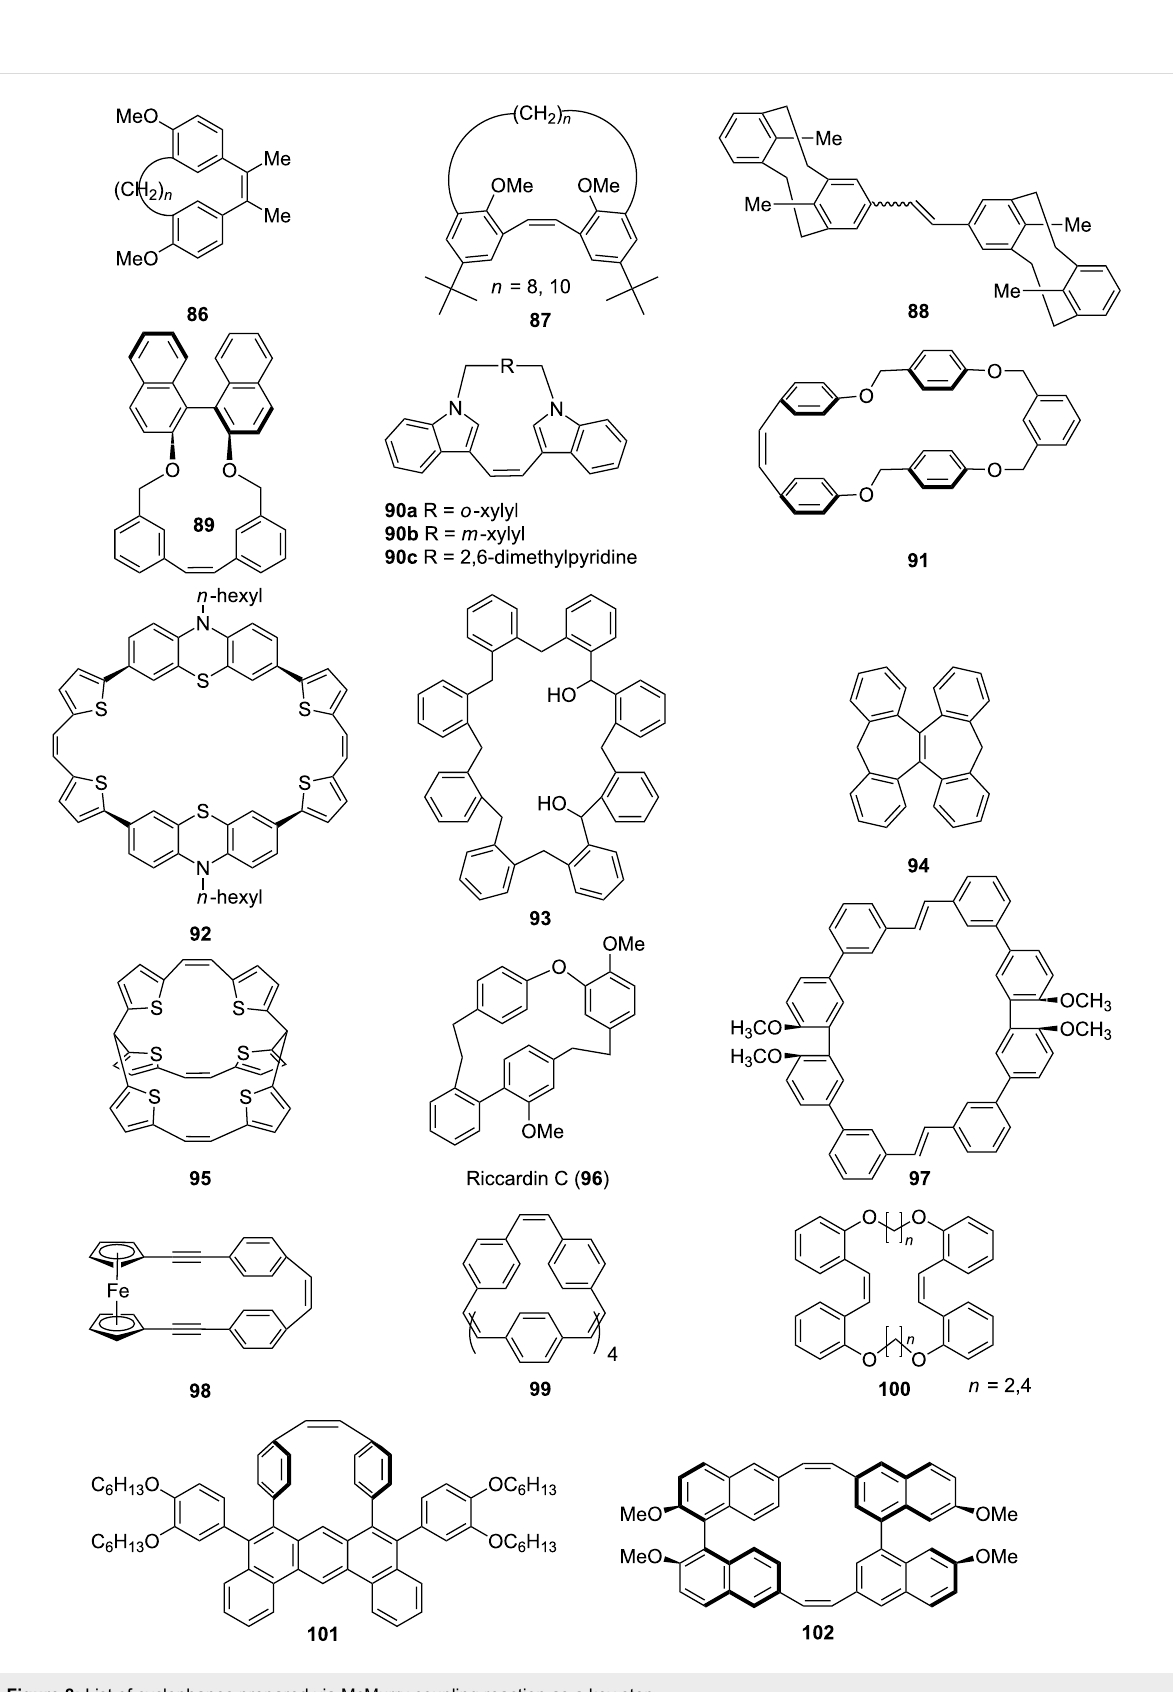
Figure 8: List of cyclophanes prepared via McMurry coupling reaction as a key